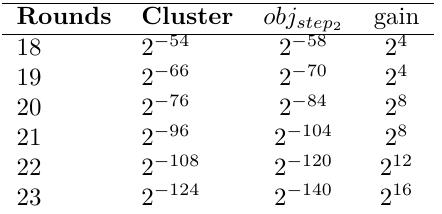
Table 4: Best distinguishers found after 2 days when summing up boomerang characteristics in the same cluster for the best Step 1 solutions.